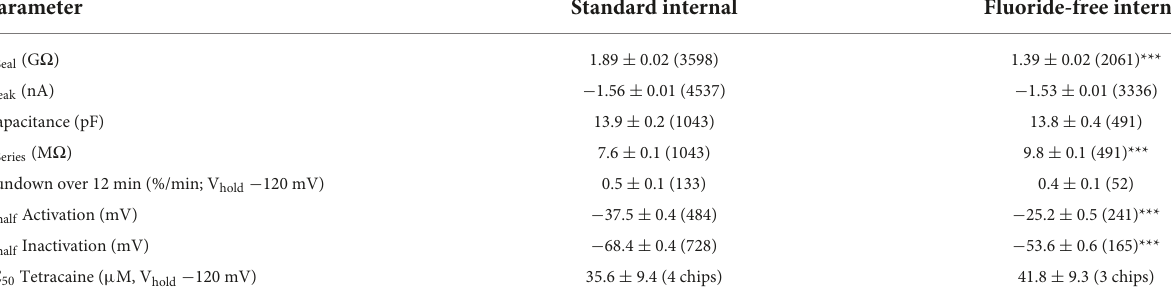
TABLE 3 Parameters for R Seal , I Peak , rundown, V half Activation, V half Inactivation, and tetracaine IC 50 for CHO cells expressing Na V 1.5 for standard internal and fluoride-free internal solution. Parameter Standard